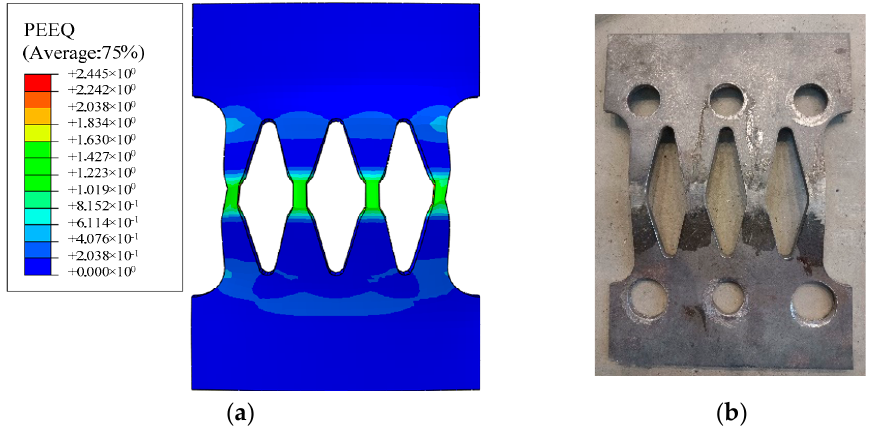
Figure 10. Comparison of EREDL deformation results. ( a ) Finite element model. ( b ) Experiment.